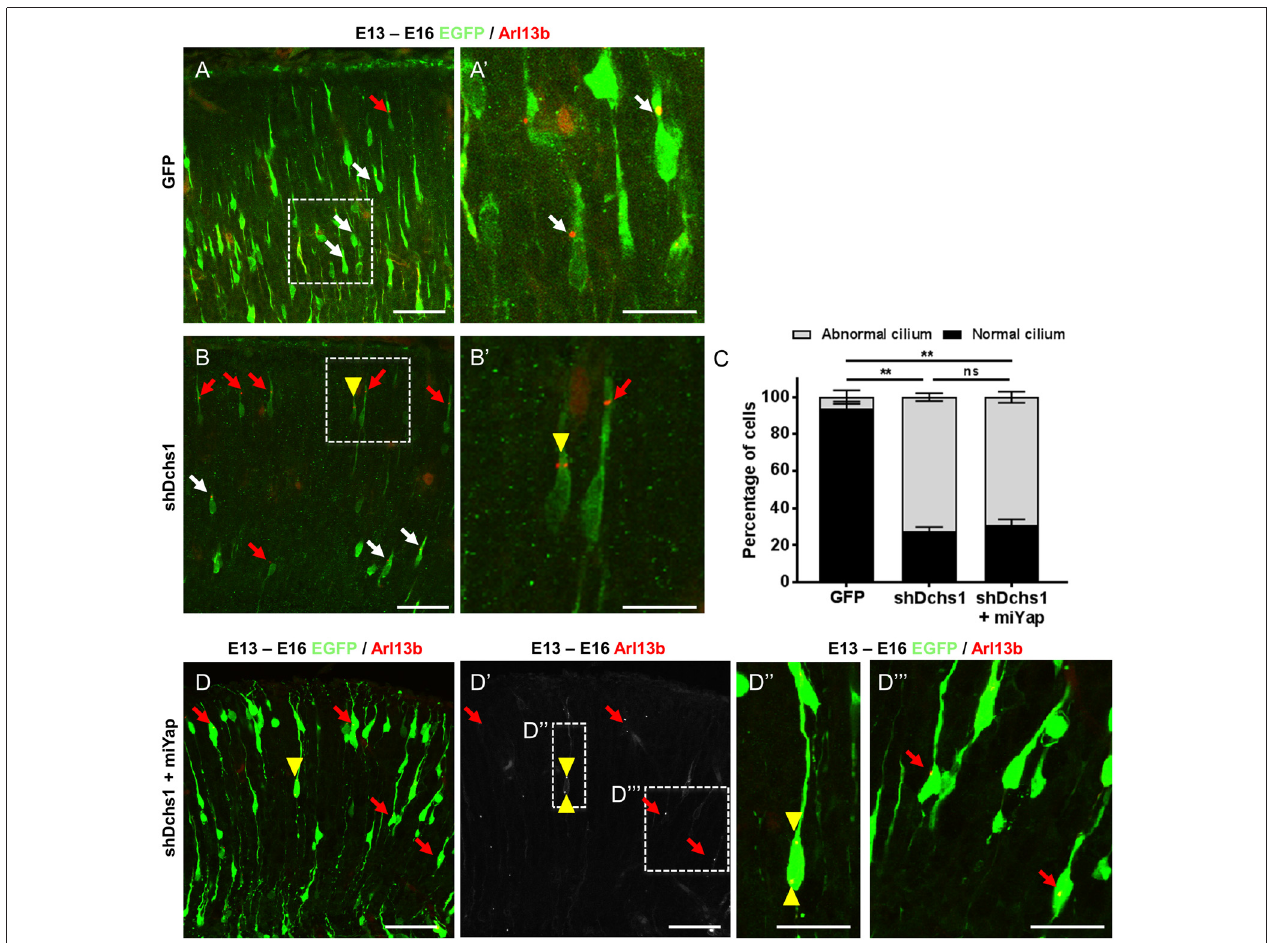
FIGURE 3 | Dchs1 knockdown in the developing mouse cortex alters nucleus-cilia coupling that cannot be rescued by Yap knockdown. (A,B,D) Representative images of migrating neurons located within bin 5 (CP2) in E16 cortices (3 dpe) electroporated with EGFP/control, miRNA targeting Yap and/or shRNA targeting Dchs1 (green) and Arl13b-tagRFP (red). White and red arrows indicate migrating neurons with correct or abnormal nucleus-cilia coupling as defined by position, respectively. Yellow arrow head shows migrating neurons with multiple cilia. (C) Quantification of the percentage of cells with abnormal nucleus-cilia coupling. Results represented as mean ( ± SEM). One-way ANOVA with Tukey HSD correction; ∗∗ p < 0.001; ns, not significant. Scale bar represents (A,B,D,D (cid:48) ) 50 µ m and (A (cid:48) ,B (cid:48) ,D (cid:48)(cid:48) ,D (cid:48)(cid:48)(cid:48) ) 20 µ